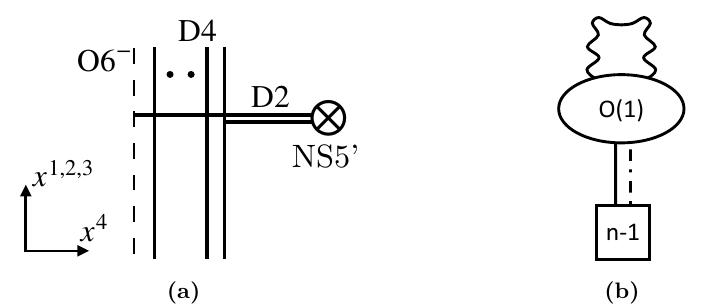
Figure 23. (a). The brane configuration that describes the monopole screening sector v = e N and the contribution Z 0 ( a ) in h T i . (b). The corresponding quiver ∧ 2 V mono ,N